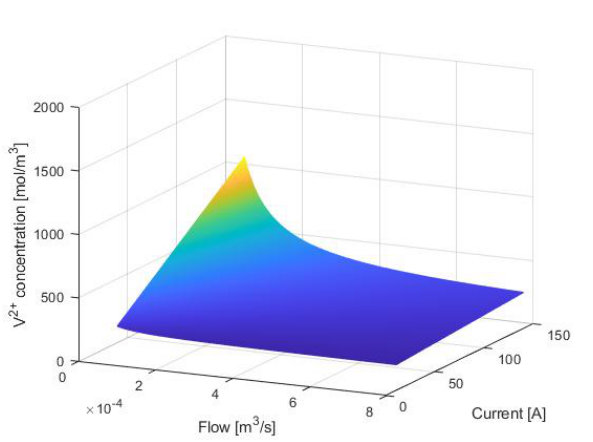
Figure 2. Equilibrium points of V 2 + for a 10% of state of charge (SOC).